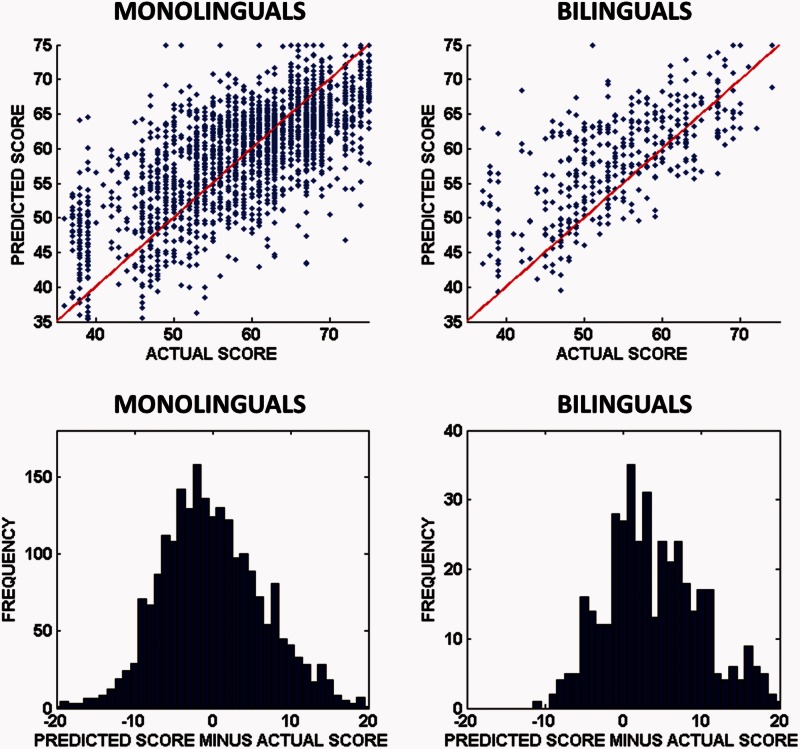
Predictions and prediction errors, by patient group, in tasks where significant group differences were observed. Top: Scatter plots of the predicted versus actual scores in each of the 13(/22) tasks where significant differences were observed in Table 3; predicted and actual scores are equal along the red line in each case (i.e. perfect predictions would fall along this line). Note that the predictions for the bilingual group (top right) tend to fall above the red line, which means that predicted scores tend to be higher than actual scores in these tasks. Bottom: Histograms of the prediction errors for predictions made in each of the same 13 tasks; the distribution for the monolingual group is centred close to zero (mean = −0.018), whereas the distribution for the bilingual group is positive (mean = 4.07).